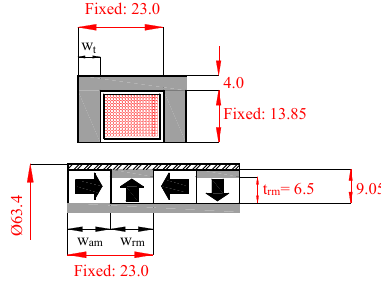
Figure 7. Factors for optimization (mm) [10].